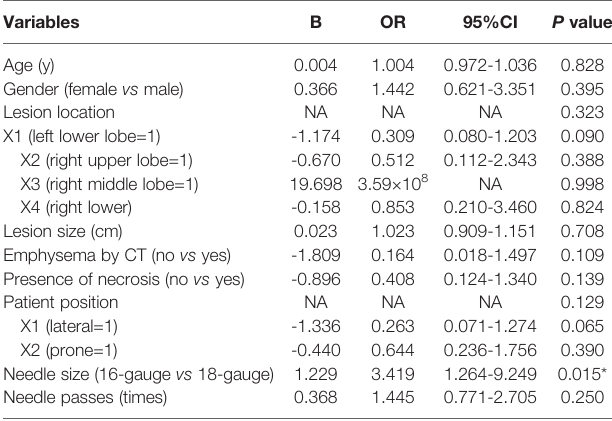
adequacy of ultrasound-guided percutaneous core needle biopsy for PPLs ≤ 2 cm. Variables B OR